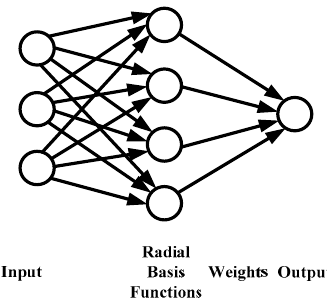
Figure 3. Illustration of RBF (radial basis function) network.